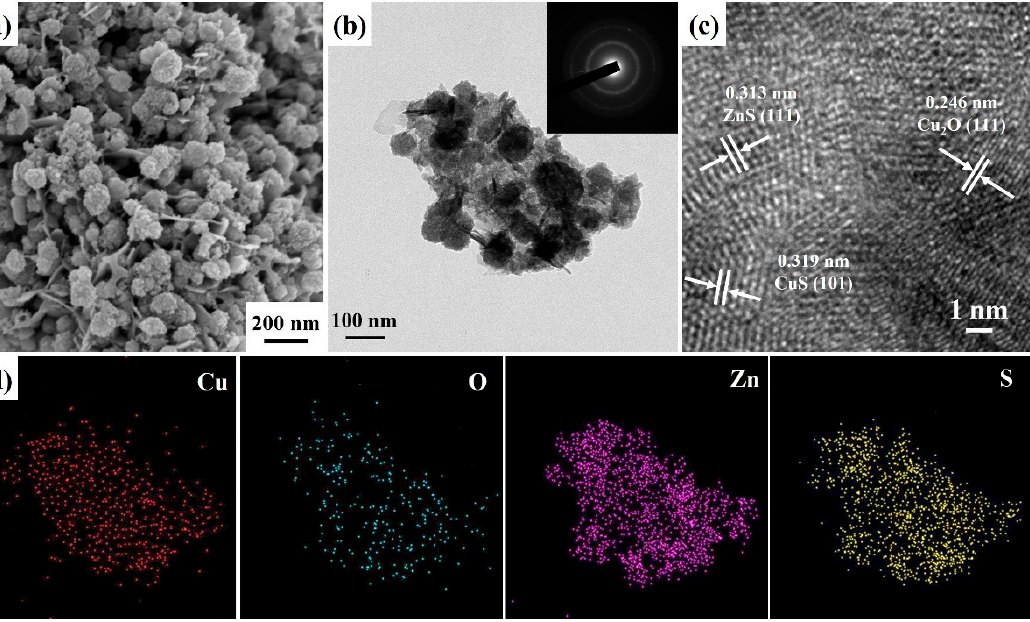
Figure 3. ( a ) FE-SEM, ( b ) FE-TEM and SAED pattern (inset), ( c ) HRTEM, and ( d ) EDS mapping images of the Cu 2 O/CuS/ZnS nanocomposite grown at the 10 mM ZnS precursor and 20 min reac- tion time.